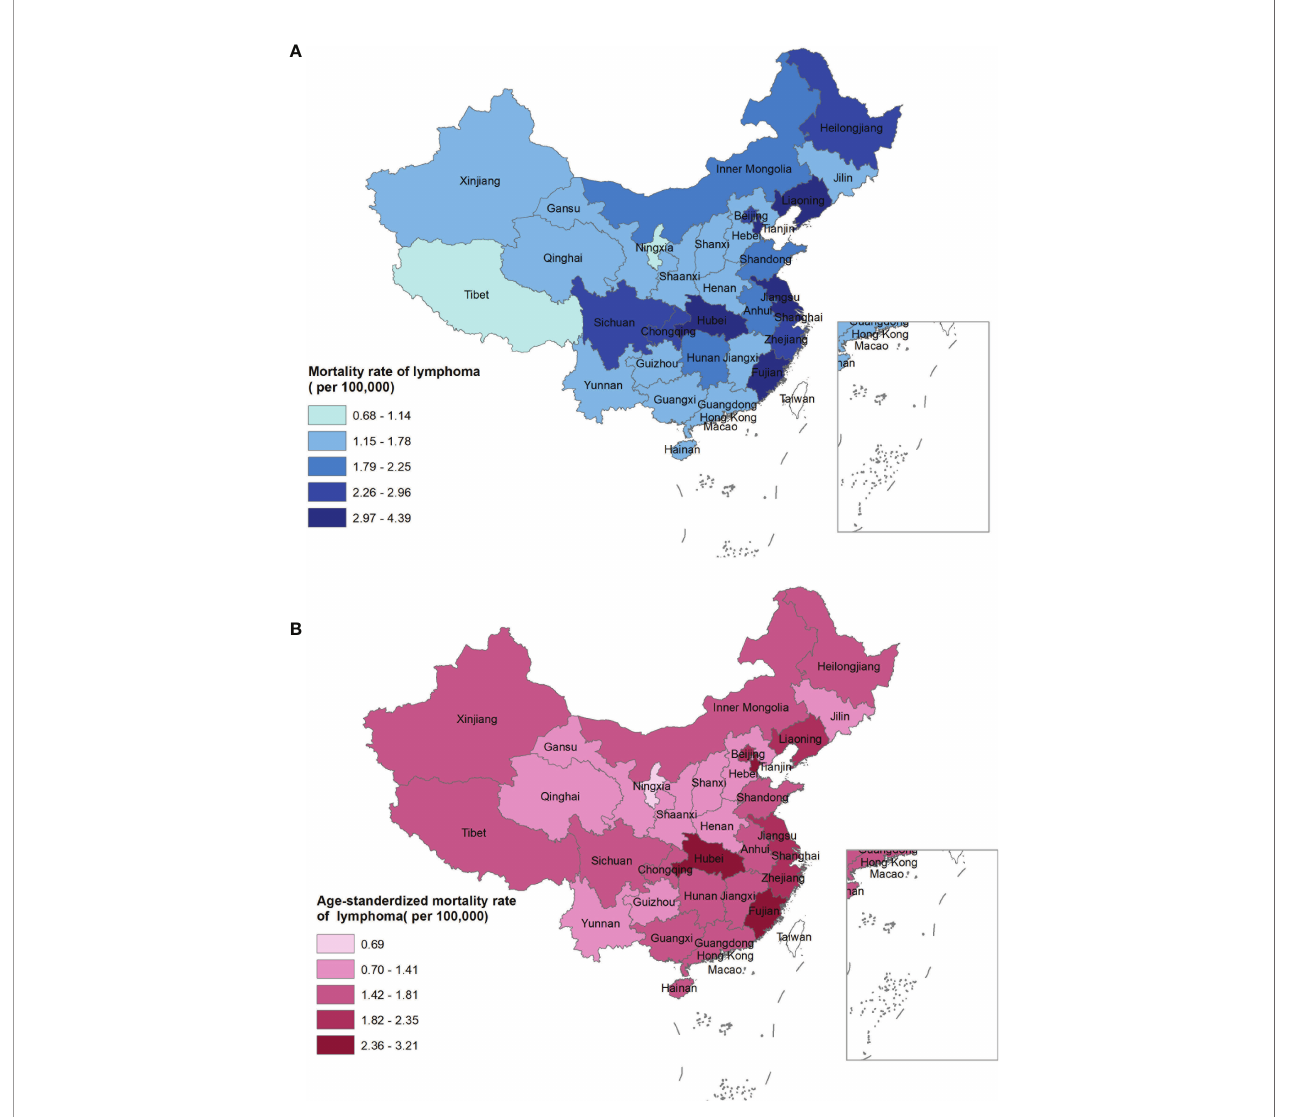
FIGURE 2 | Crude mortality rate (A) and age-standardized mortality rate of China (B) of lymphoma for both sexes by provinces in 2020,